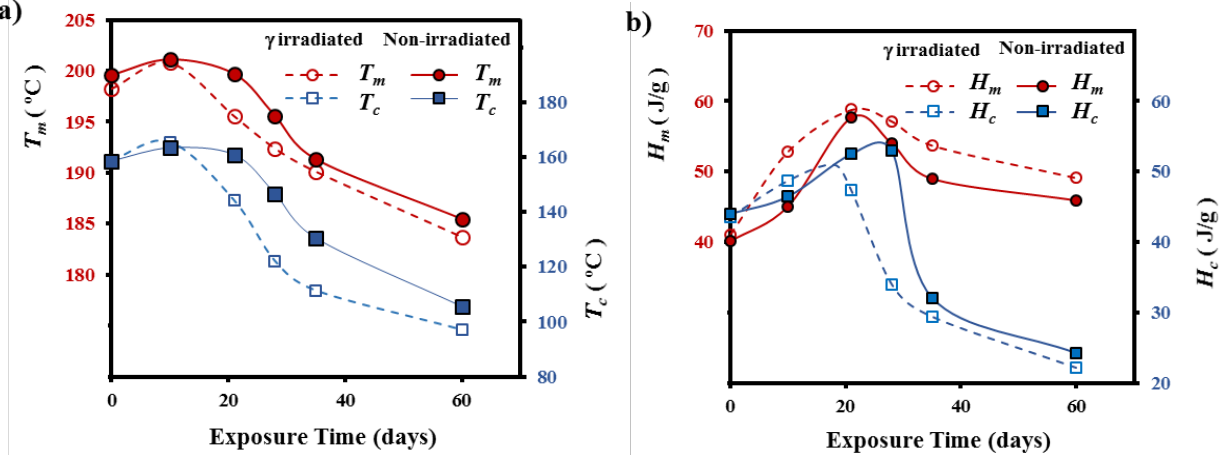
Figure 7. ( a ) Variation of melting and crystallization temperature and ( b ) melting and crystallization enthalpies of non-irradiated and γ irradiated GL- b -[GL- co -TMC- co -CL]- b -GL samples during exposure time in a pH 7 buffer